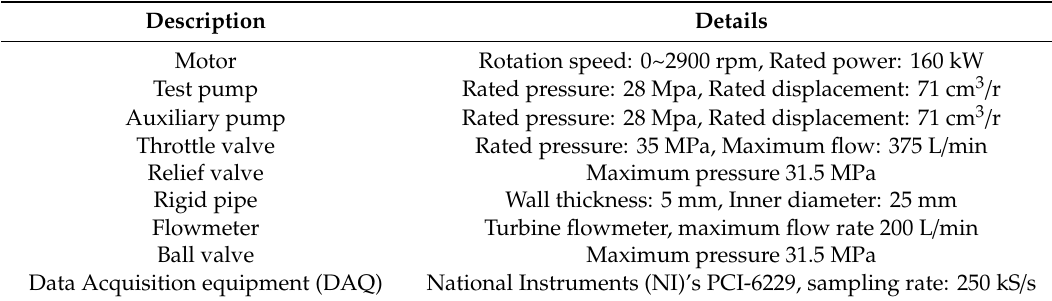
Figure 3. Schematic diagram of the test system. Table 1. Details of the test hydraulic system.